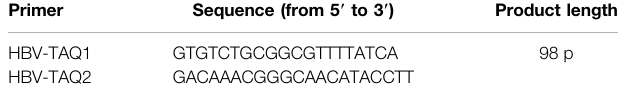
Frontiers in Molecular Biosciences |